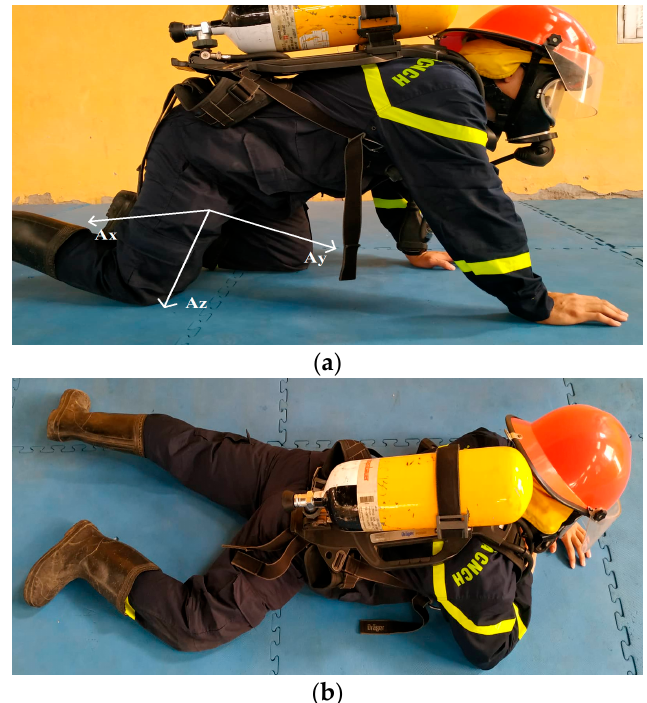
Figure 10. The volunteer is carrying the support device in his trouser pocket in the crawling state with the side view (a) and the down view (b)